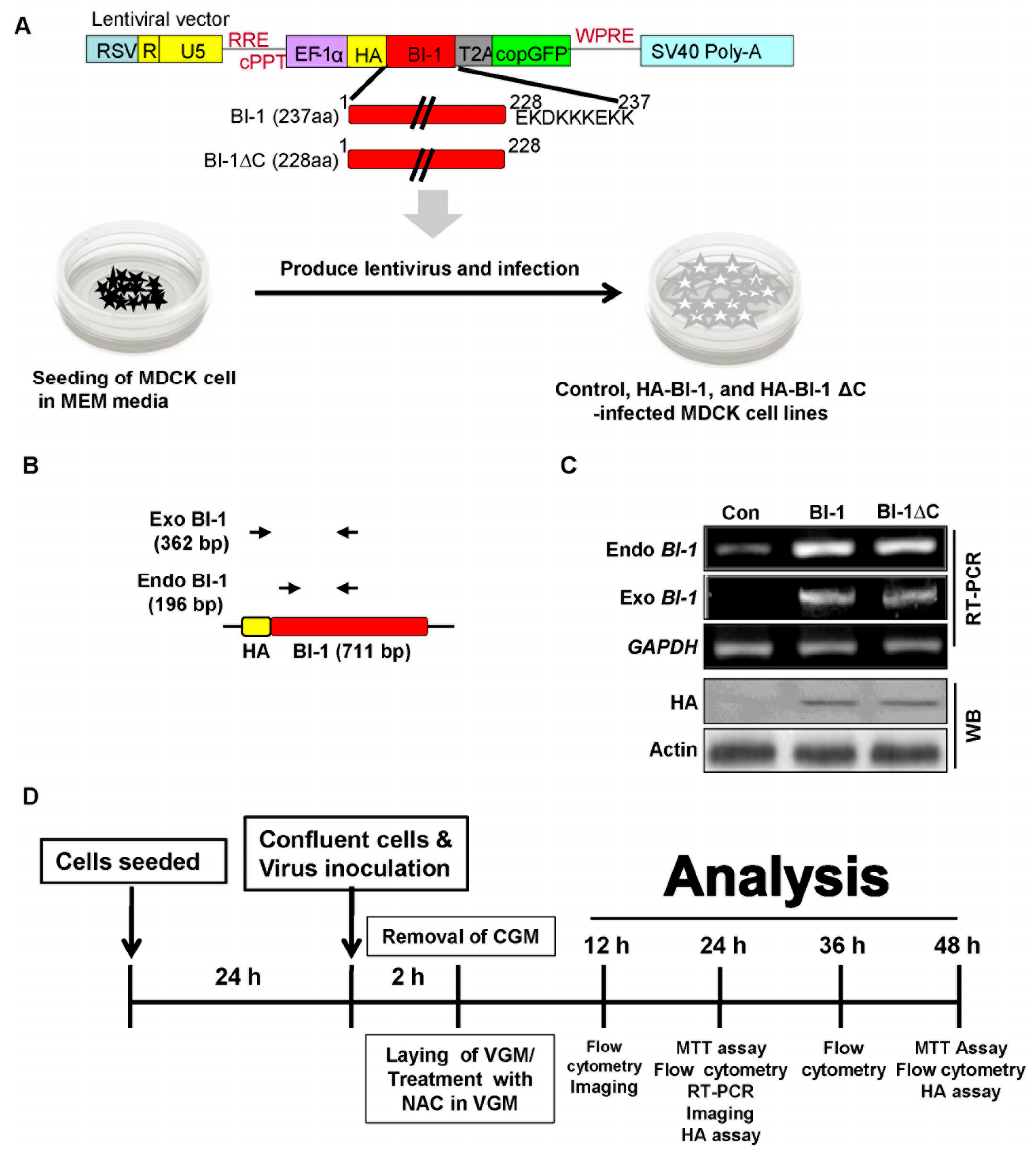
Figure 1. Overexpression and endogenous or exogenous expression of BI-1 or BI-1 ∆ C in Madin-Darby Canine Kidney (MDCK) cells. ( A ) Scheme of the lentiviral constructs for the expression of wild type BI-1 or nonfunctional mutant BI-1 Δ C in MDCK cells. BI-1 or BI-1 Δ C was inserted into the lentiviral pEF vector. The pEF lentivirus containing wild type BI-1 or the non-functional mutant BI-1 Δ C was produced and used to infect MDCK cells. ( B ) Illustration of specific primer sets which was used to analyze endogenous or exogenous expression of BI-1 . ( C ) The endogenous or exogenous expression of BI-1 was confirmed by RT-PCR analysis in indicated cells; and the expression of HA was confirmed by western blot analysis in indicated cells. The expression of GAPDH and Actin was used as loading control. ( D ) The illustration of whole experimental protocol used in this study. (Abbreviations: chimeric Rous sarcoma virus (RSV) sequence, Rev response elements (RRE), central polypurine tract (cPPT), elongation factor 1 alpha (EF - 1 α ) promoter region, a copGFP (copepod GFP) tag, a woodchuck hepatitis virus post-transcriptional regulatory element (WPRE), cells growth media (CGM), virus growth media (VGM), and hemagglutinin assay (HA assay)).